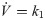
A is formed by zero-order kinetics within the cell while the cellular volume increases with a constant rate V˙=k1.